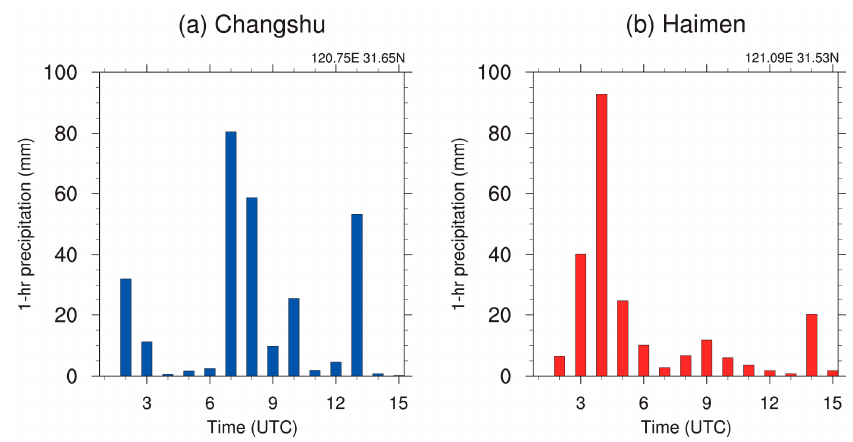
Figure 2. Time series of 1-h precipitation amount (mm) at ( a ) Changshu and ( b ) Haimen during 0100 ‒ 1500 UTC 16 September 2018.